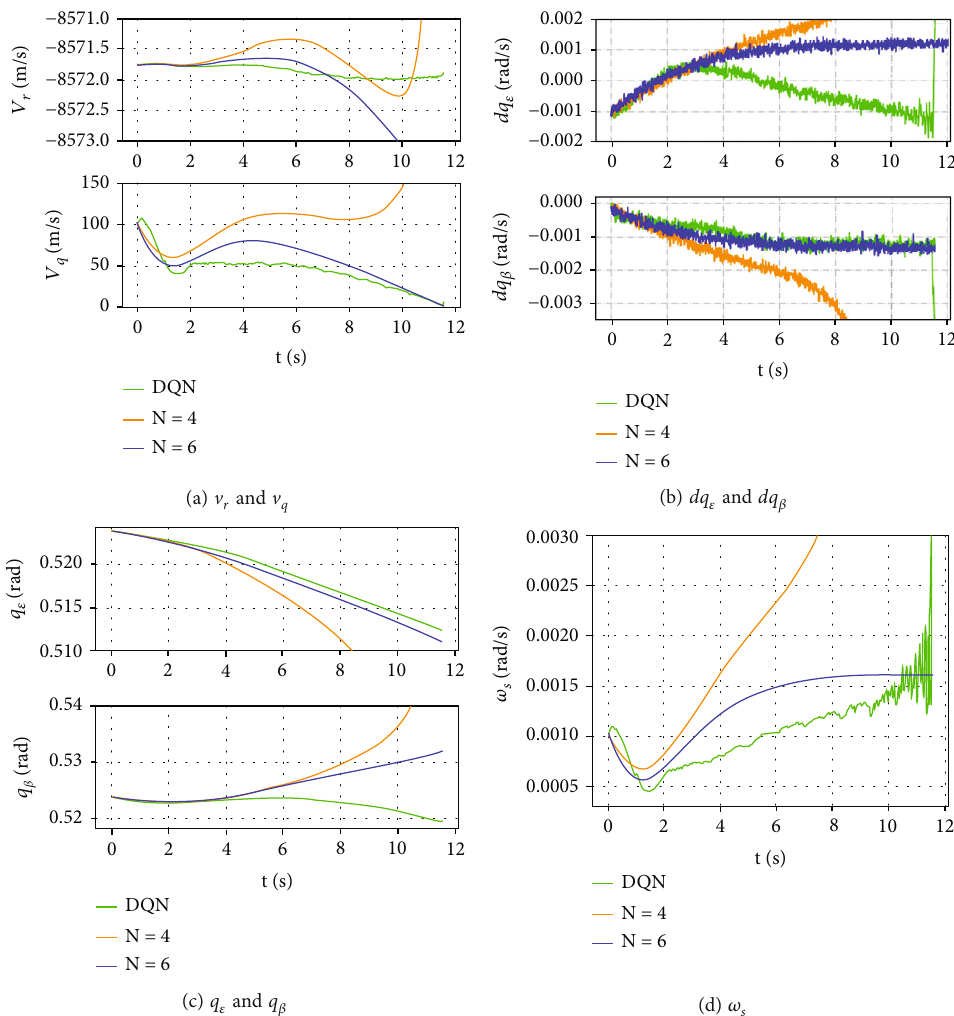
Figure 9: DQN simulation results of constant-maneuvering target.